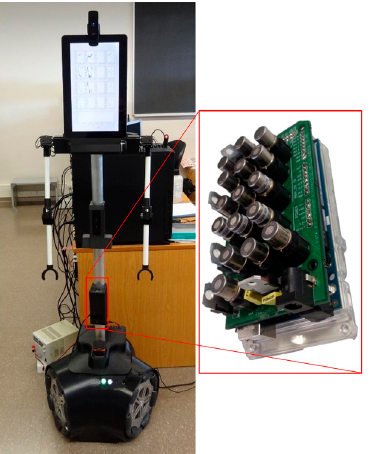
Figure 1. Image of the assistant personal robot (APR-02) and detail of the array of metal-oxide (MOX) gas sensors used for early gas leakage detection.